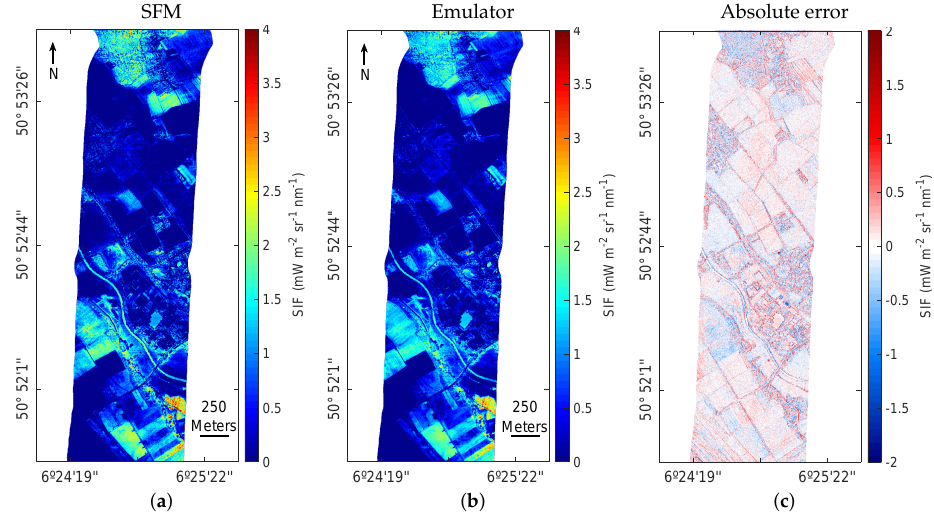
Figure 8. L2 SFM ( b ) and emulated SIF map at 760 nm ( c ) as well as the absolute error map ( a ) calculated as the difference of both